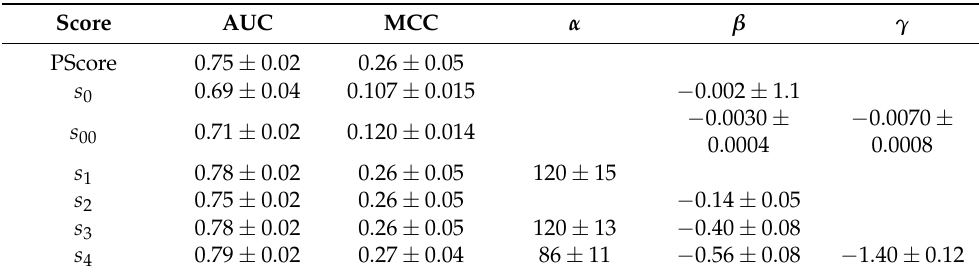
Table 2. Typical values of AUC and MCC on the test set using LLPS as the positive set and hsnLLPS as the negative set. The optimised parameters α , β and γ are also summarised here ( ˜ β and ˜ γ are actually reported for scores s 0 and s 00 ). The numerical entries are the mean or the median (depending on whether the quantity follows a normal distribution or not, respectively, see File S1) ± the standard deviation of the corresponding quantity.